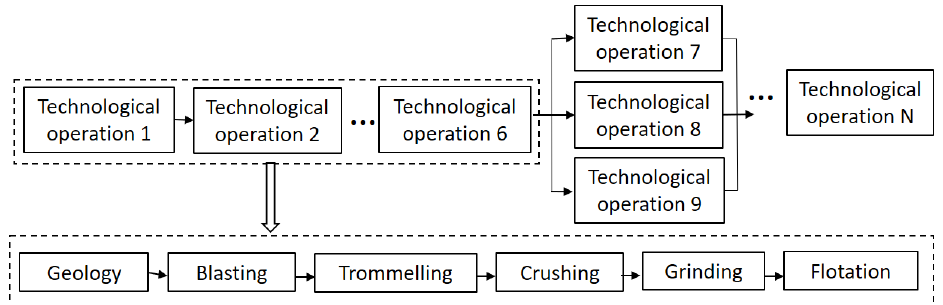
Figure 1. Scheme of technological processes at a mining production.